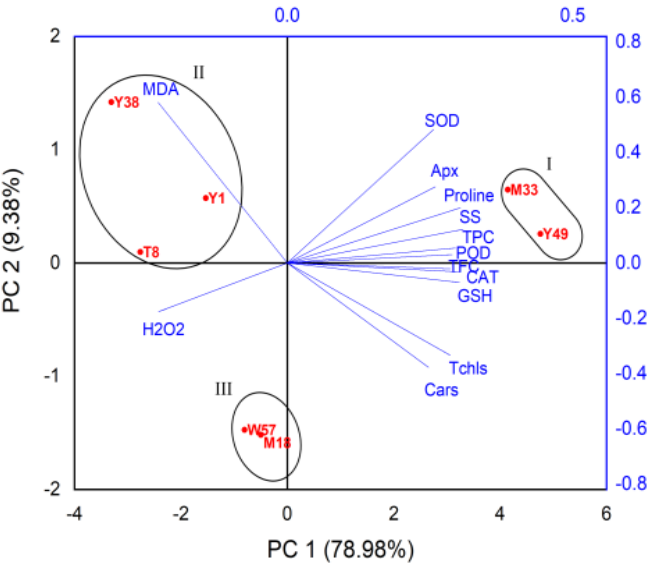
Figure 5. Biplot for the first two principal components (PC1 and PC2) was shown using the principal component analysis (PCA) with all measured parameters and 7 varieties.